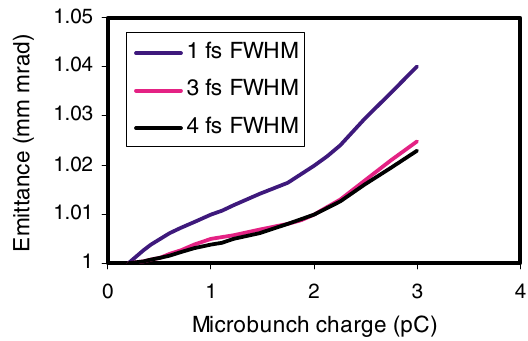
FIG. 5. (Color) Transverse emittance versus microbunch charge at different microbunch lengths.